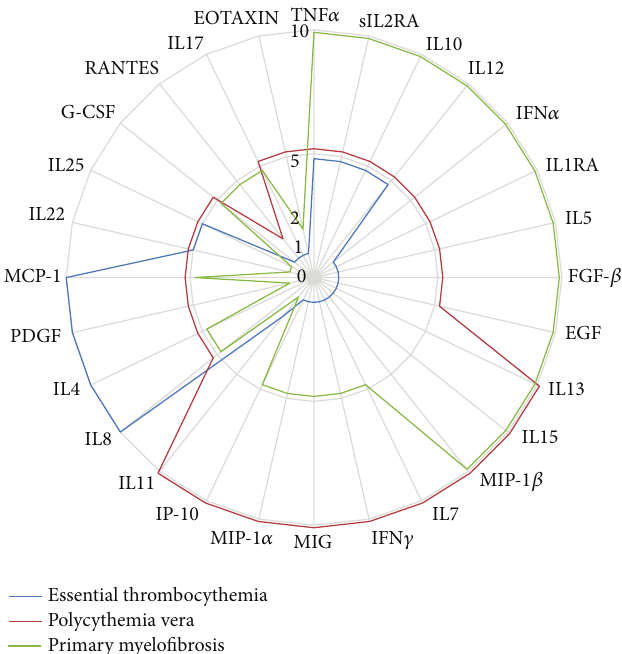
Figure1:RadargraphofrelativecytokineexpressionprofilesaccordingtoMPNsubtypes.Datawereanalysedfrom6studies[6,13–16,45].For each myeloproliferative neoplasm, arbitrary scores were attributed to different cytokines according to their relative variations: 10 corresponds to an overexpression of cytokines compared to one or both MPNs; 2 corresponds to underexpression compared to one or both MPNs; 1 was attributed where no data was found in literature; 5 represents intermediary cytokine level. In cases of discordances between several studies, data are not added in this